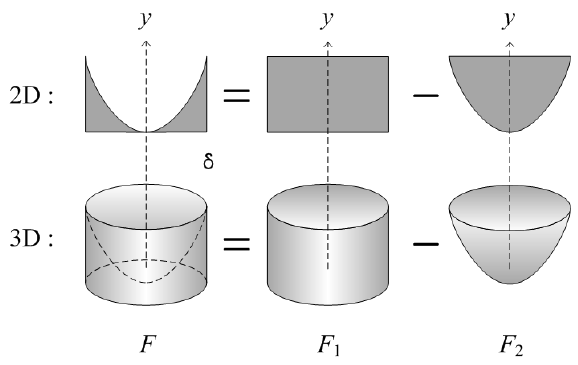
Figure 5. Calculation of peak tensile force.